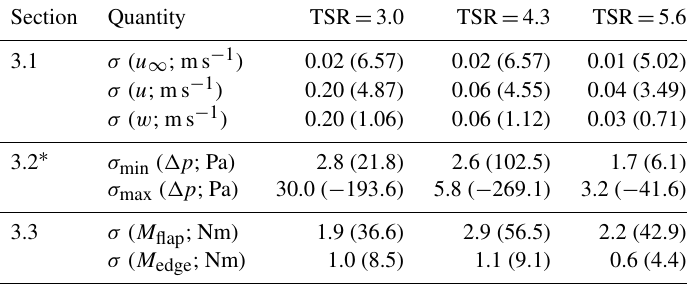
Table B1. Standard deviation and reference values in brackets. Section